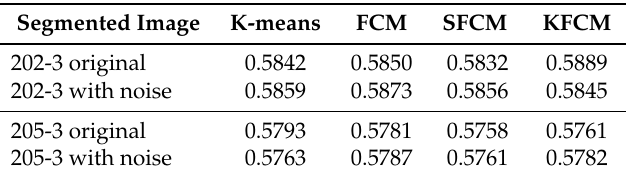
Table 4. Average segmentation results obtained by different clustering algorithms on the test images.